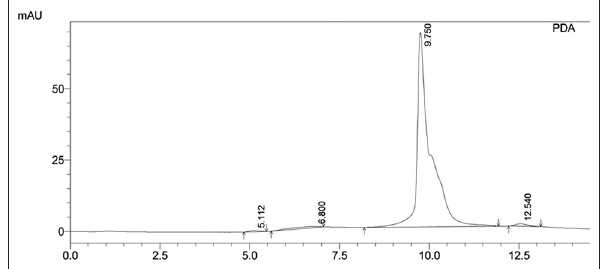
Figure-5: Aflatoxin B (1.5 ppm) in matrix samples after 1 separated by solid phase extraction showed a retention time of 9.750 min, with an impurities peak at 12.546 min (mobile phase at pH